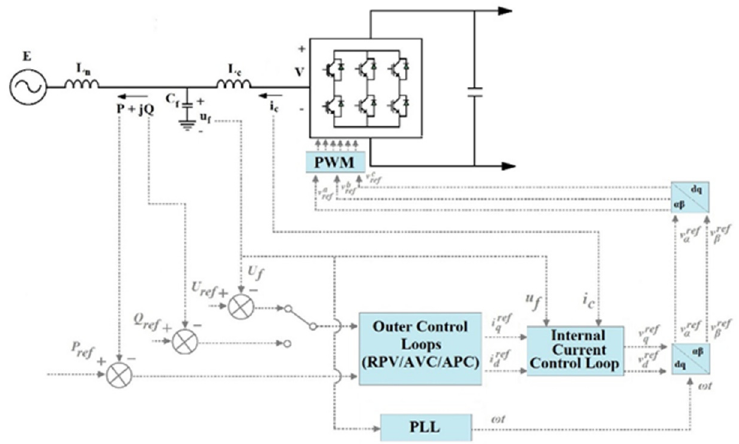
Figure 14. VSC-HVDC “vector current” control strategy.